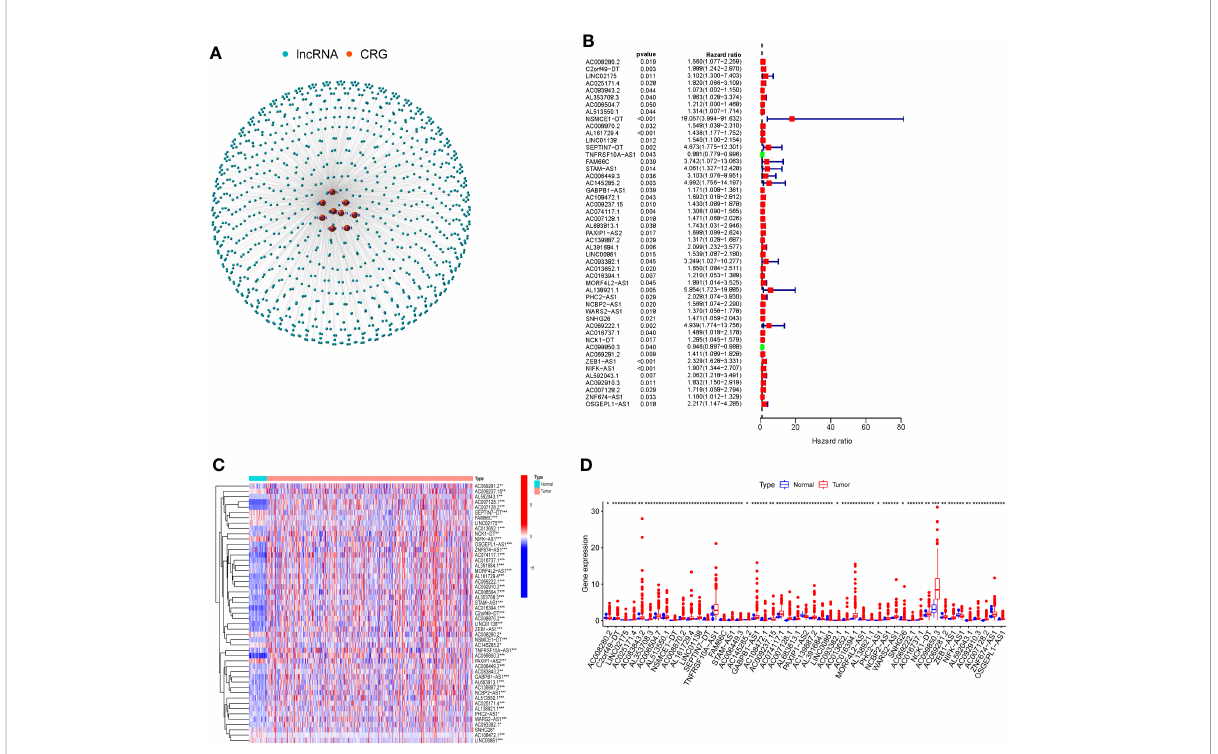
FIGURE 1 Cuproptosis-related lncRNAs (CRLs) with prognostic value were screened. (A) Co-expression network of cuproptosis-related genes and CRLs by Pearson correlation analysis. (B) There were 49 CRLs found to have prognostic value by COX regression analysis with one variable. (C) Heat map of prognosis-related CRLs expression in COAD and normal tissues. (D) The expression of prognosis-related CRLs in COAD and normal tissues was shown in box plots. (* P < 0.05, ** P < 0.01, *** P <